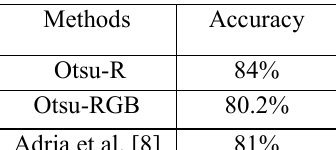
Table 4. Comparison with the Existing Methods